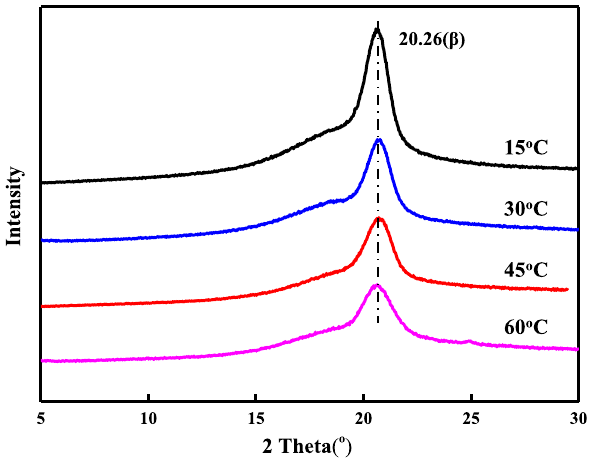
Fig. 5 XRD results of PVDF membranes produced with different quenching